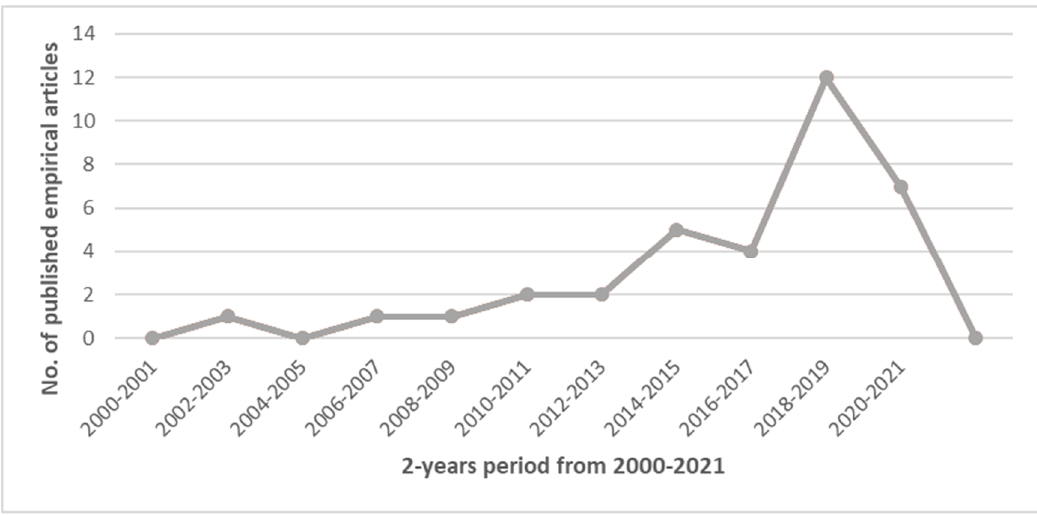
Figure 2. Distribution of reviewed articles over a two-year period.